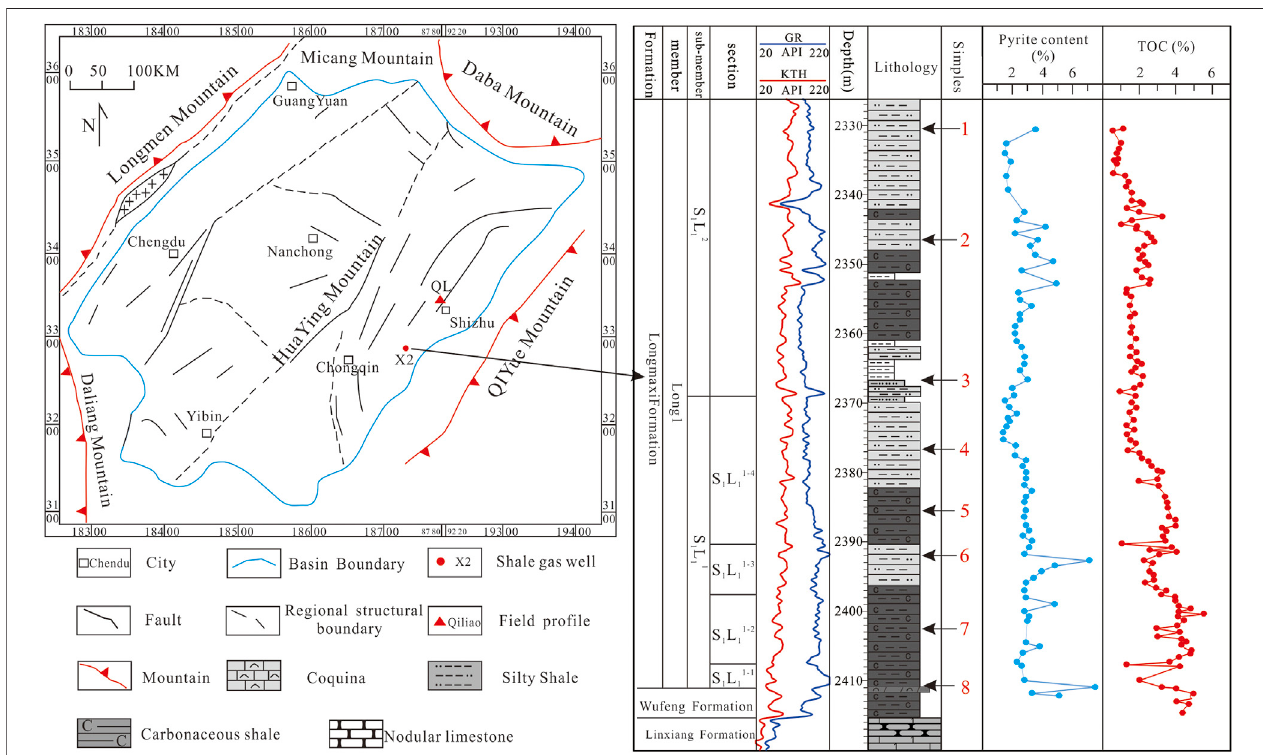
FIGURE 1 | Location of the study area and stratigraphic column of the Longmaxi Formation and the gamma-ray log of the X2 well (Wang et al., 2002).